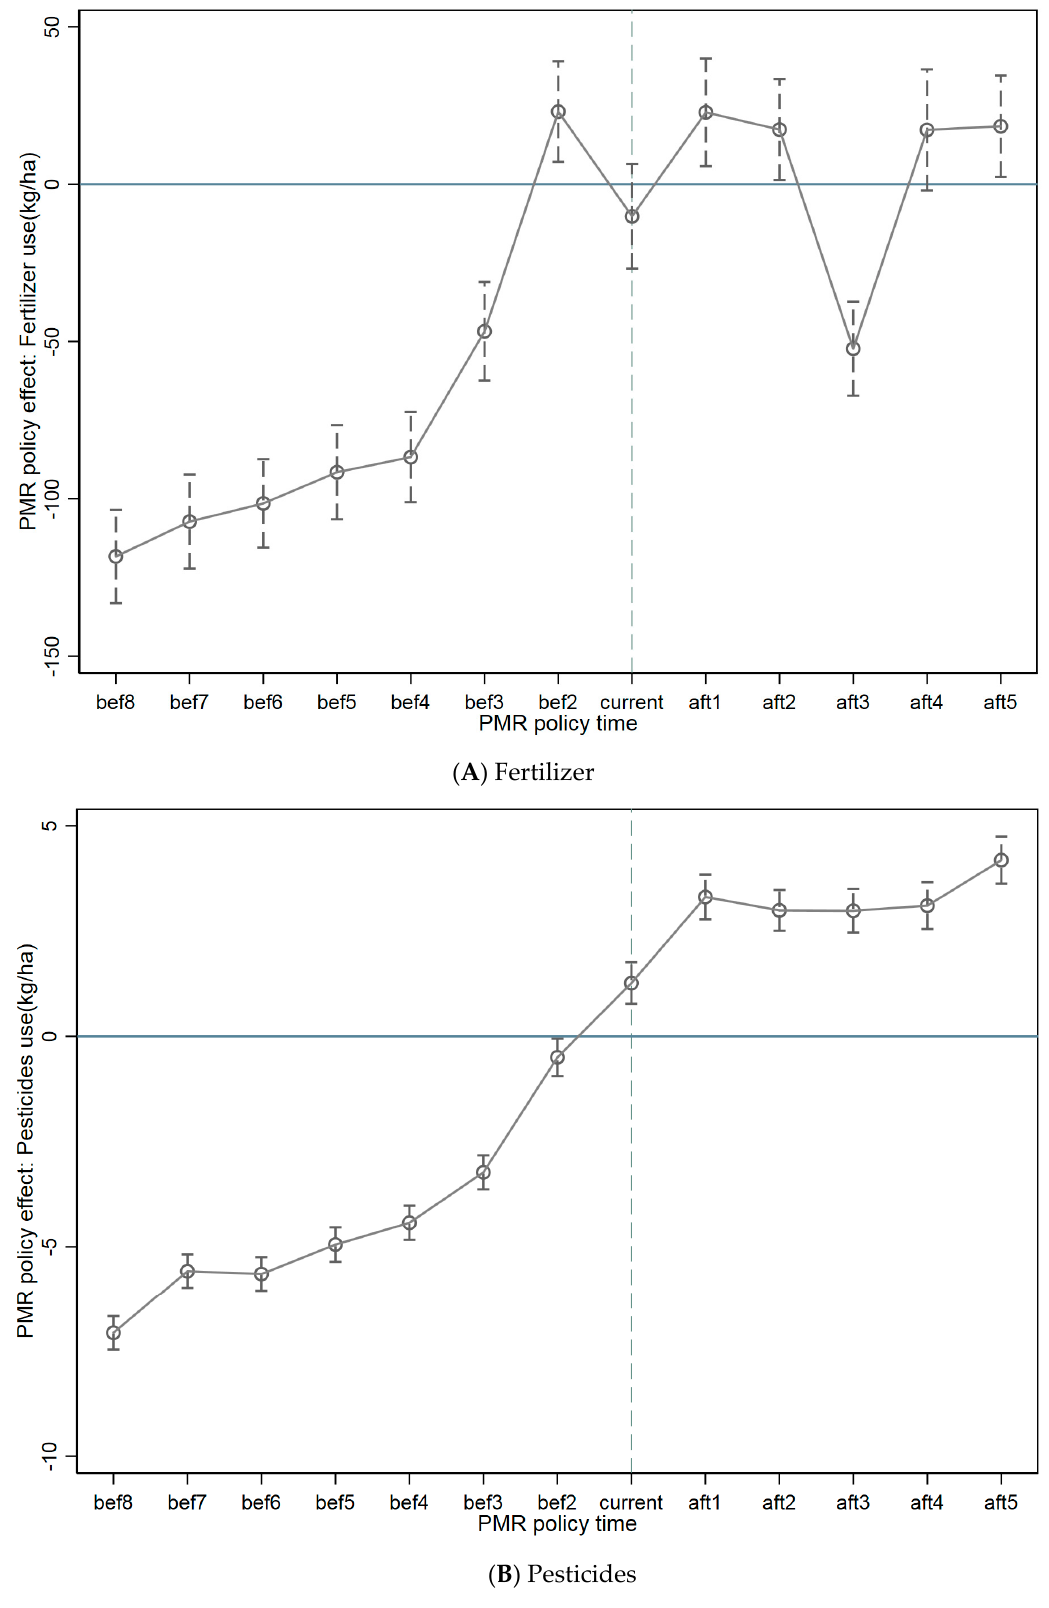
Figure A3. Parallel trends of the PMR program for ( A ) Fertilizer and ( B ) Pesticides. In kg/ha; For a 95% confidence interval. Source: Calculated from the RFOP survey data set 1997–2010.